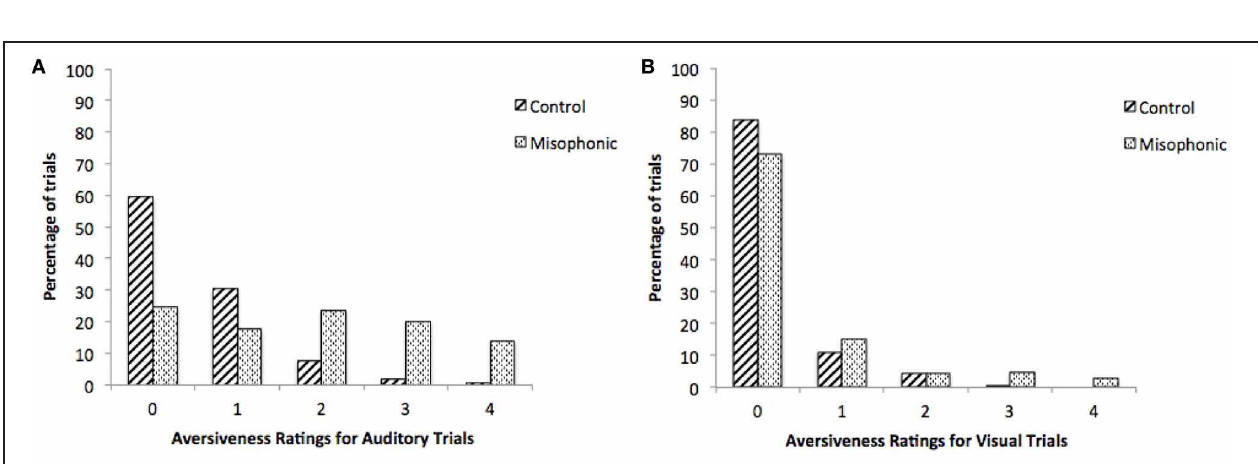
FIGURE 3 | Percentage of trials per index on the 5-point aversiveness scale, for controls and misophonics, during (A) auditory and (B) visual